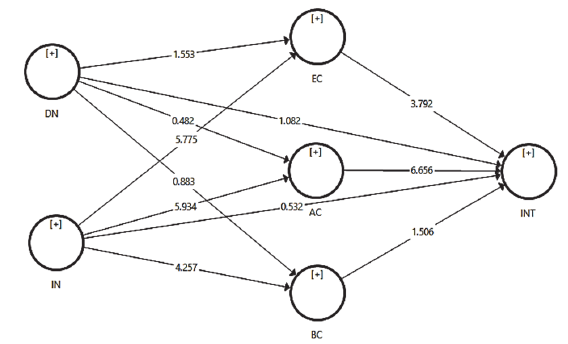
Fig. 3. PLS Bootstrapping for the Mediation of Environmental Concern